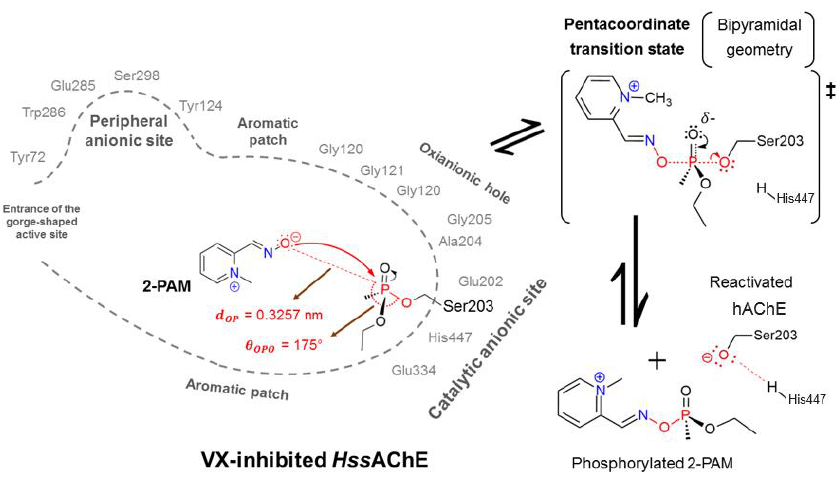
Figure 1. Representation of the near attack conformation (NAC) obtained before for deprotonated 2-PAM inside VX-inhibited Hss AChE after docking and molecular-dynamics (MD) simulations [20].